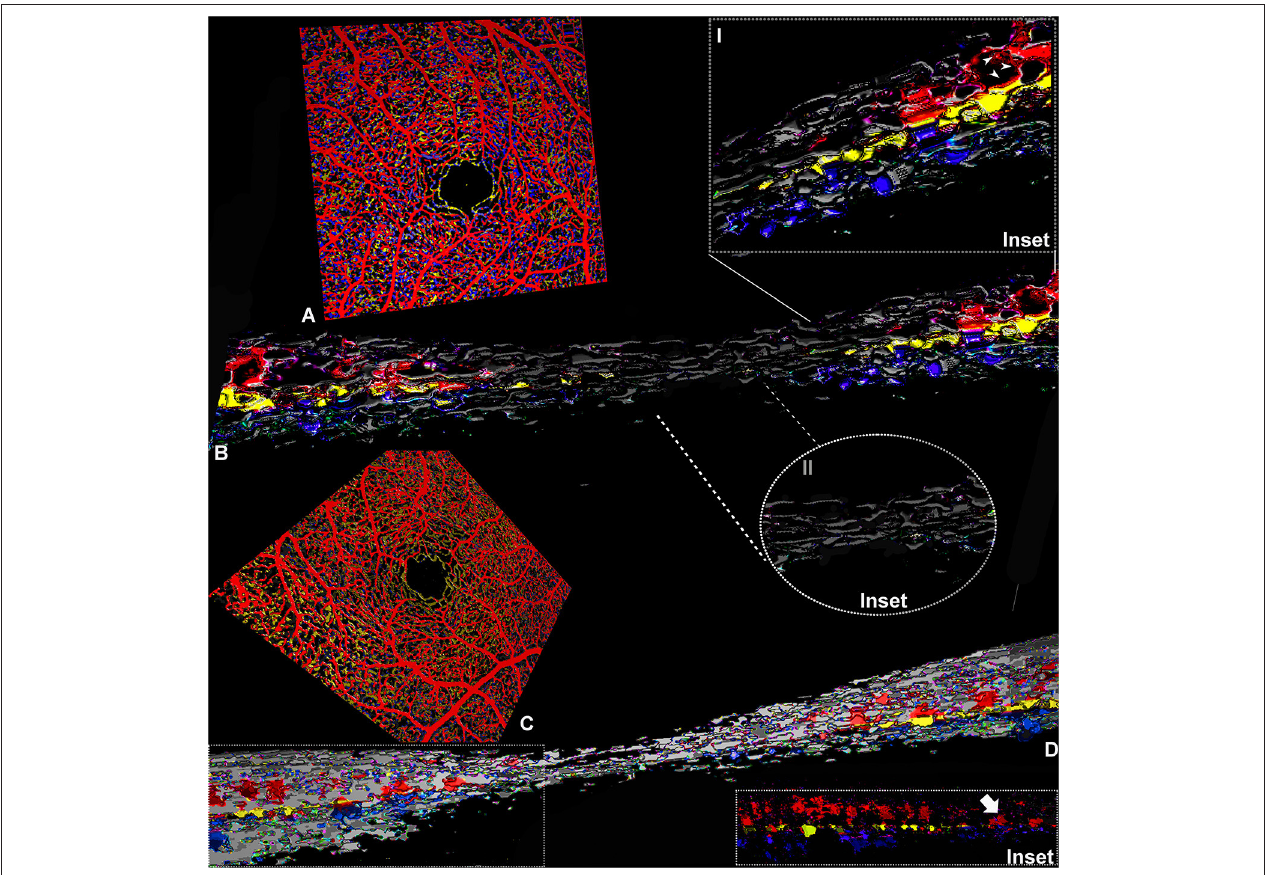
FIGURE 3 | Three-dimensional evaluation of the capillary networks in healthy subjects. Two different representative cases, a 27-year-old male (Case 3) and a 28-year-old male (Case 4), are illustrated. Case 3: (A) Volume rendering of the en face OCTA slabs segmented as superficial (red), intermediate (yellow), and deep (blue). (B) Volume rendering obtained on consecutive OCTA b scans with a magnified parafoveal region (Inset I) and foveal avascular region (Inset II). Case 4: (C) Volume rendering of the en face OCTA slabs. (D) 3D reconstruction of consecutive OCTA b scans; the inset shows the shortest paths between SVC and DCP infrequently observed in normal eyes (white